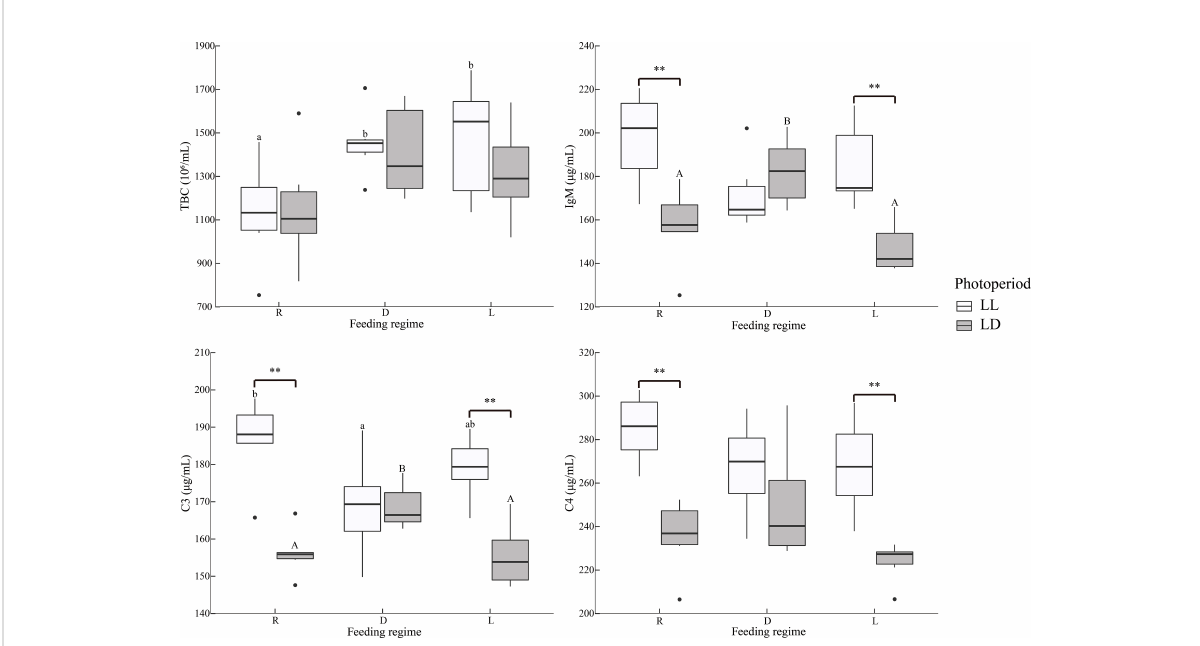
FIGURE 2 Serum immunological indicators of juvenile Oncorhynchus mykiss under different experimental treatments (n=6). TBC: Total blood cell counts, IgM: Immunoglobulins M, C3, Complement 3; C4, Complement 4; R, random feeding; D, mid-dark stage feeding; L, mid-light stage feeding; LL: 24L: 0D, LD: 12L: 12D. Different lowercase letters and capital letters indicate signi fi cant difference among different feeding regimes at the LL (24L: 0D) and LD (12L: 12D, lights-on at 6:00), respectively ( P < 0.05). Asterisks denote signi fi cant differences between photoperiods at the same feeding regime (** P < 0.01). Points outside the box plot are outliers.